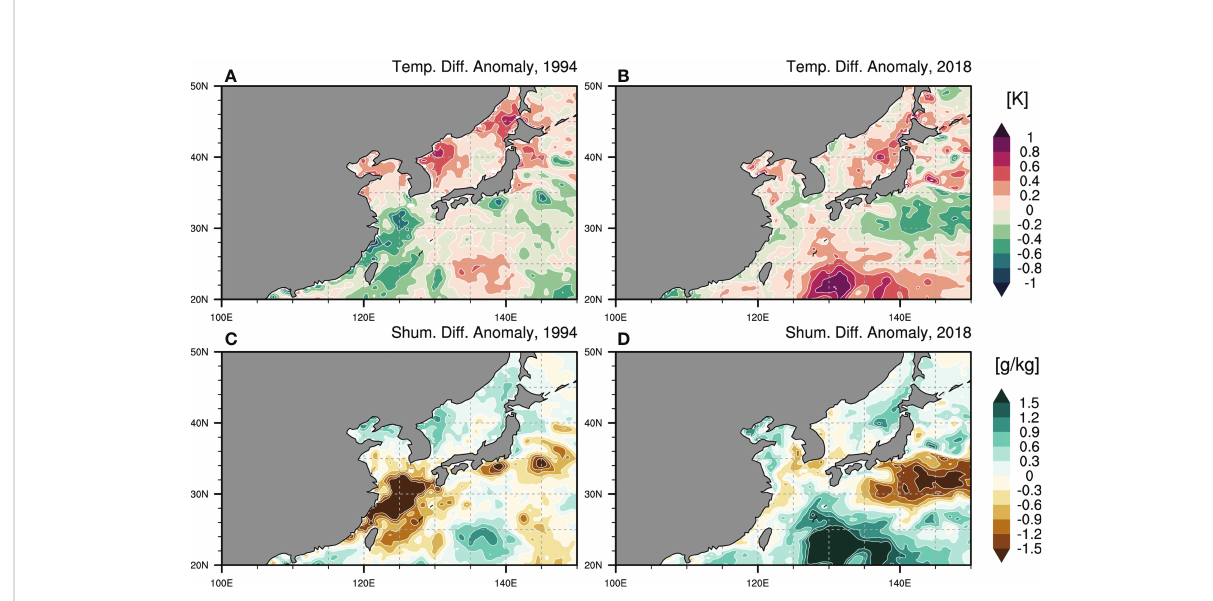
FIGURE 3 Horizontal distribution of detrended air – sea temperature difference anomalies (A, B) ; K and speci fi c humidity difference anomalies (C, D) ; g kg − 1 in July 1994 (left) and 2018 (right), respectively, in East Asia (10 – 60° N, 80 – 170° E). Shum: speci fi c humidity. All variables are used from ERA5